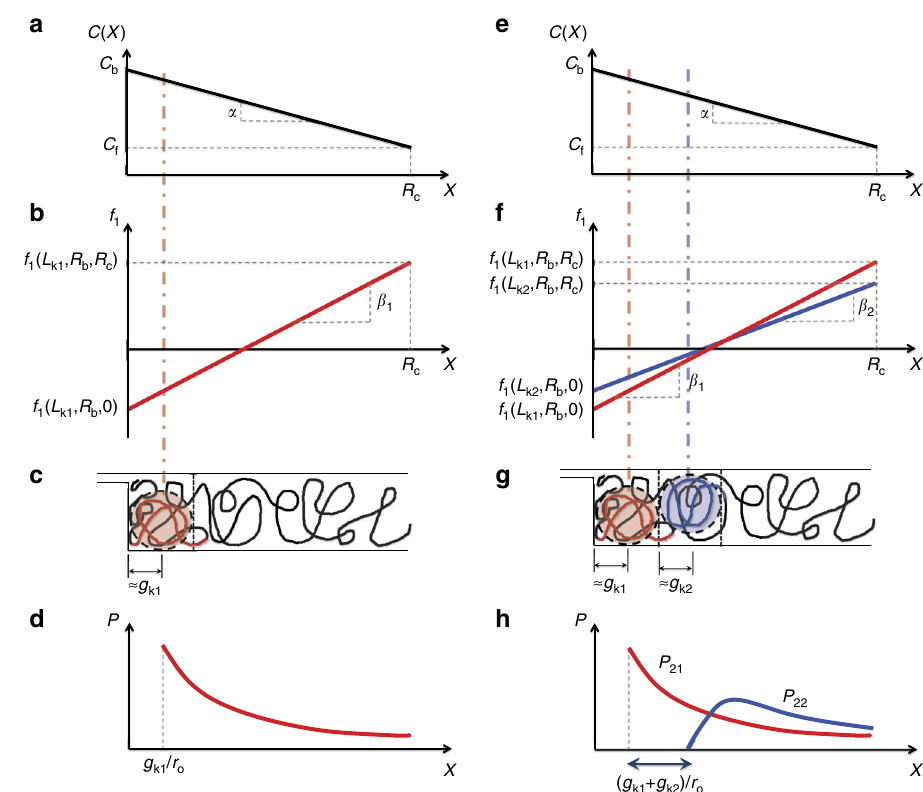
Fig. 7 Free energy and probability distribution for one and two knot states. a , e Schematic of concentration pro fi le C ( X ), b , f resulting free energy pro fi le f 1 ( L k , R b , X ), and d , h resulting knot probability distributions for single ( a – d ) and two-knot ( e – h ) states. Note that in the two-knot state the two knots can experience different free energy pro fi les due to their varying size (e.g., L k1 does not necessarily equal L k2 ): this is indicated in f by drawing two free energy pro fi les with slopes β 1 and β 2 . In addition, in the two-knot state the knots will have different probability distributions: P 21 for the lower knot closest to the barrier and P 22 for the upper knot farthest from the barrier (see Supplementary Note 7 for detailed derivation of the probabilities) ( h ). c Cartoon of single- knot on chain, displaced by radius of gyration g k1 from barrier edge. The dashed line relates the knot position to the corresponding concentration and free energy. g Cartoon of two knots on chain. Knot 1 (red) is displaced by radius of gyration g k1 from barrier edge; knot 2 (blue), by assumption of single- fi le ordering, is displaced by 2 g k1 + g k2 from barrier